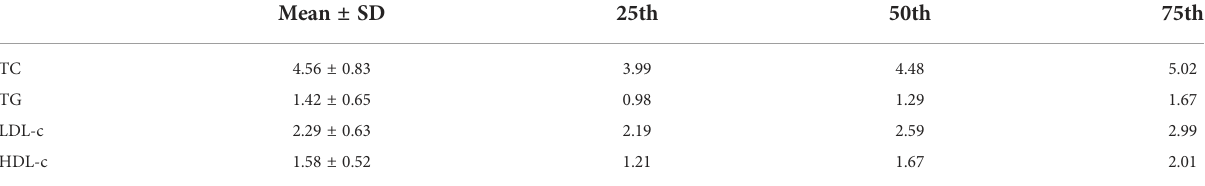
TABLE 2 Quartiles of maternal lipid pro fi les in fi rst trimester